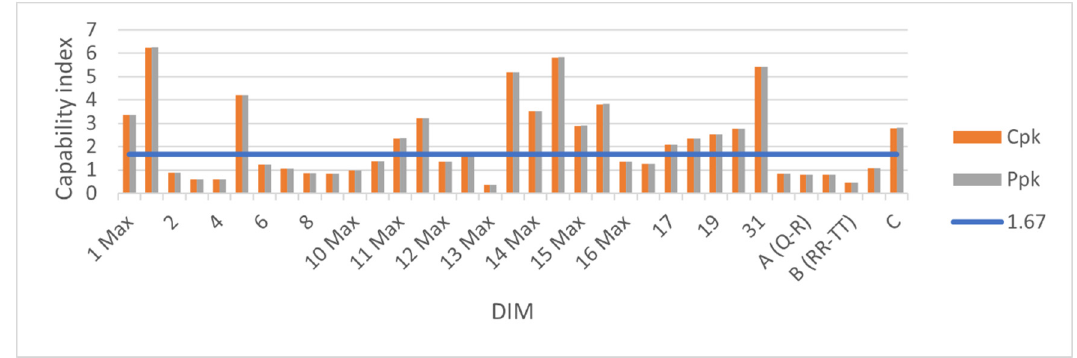
Figure 13. Plot of capability index for all DIMs.